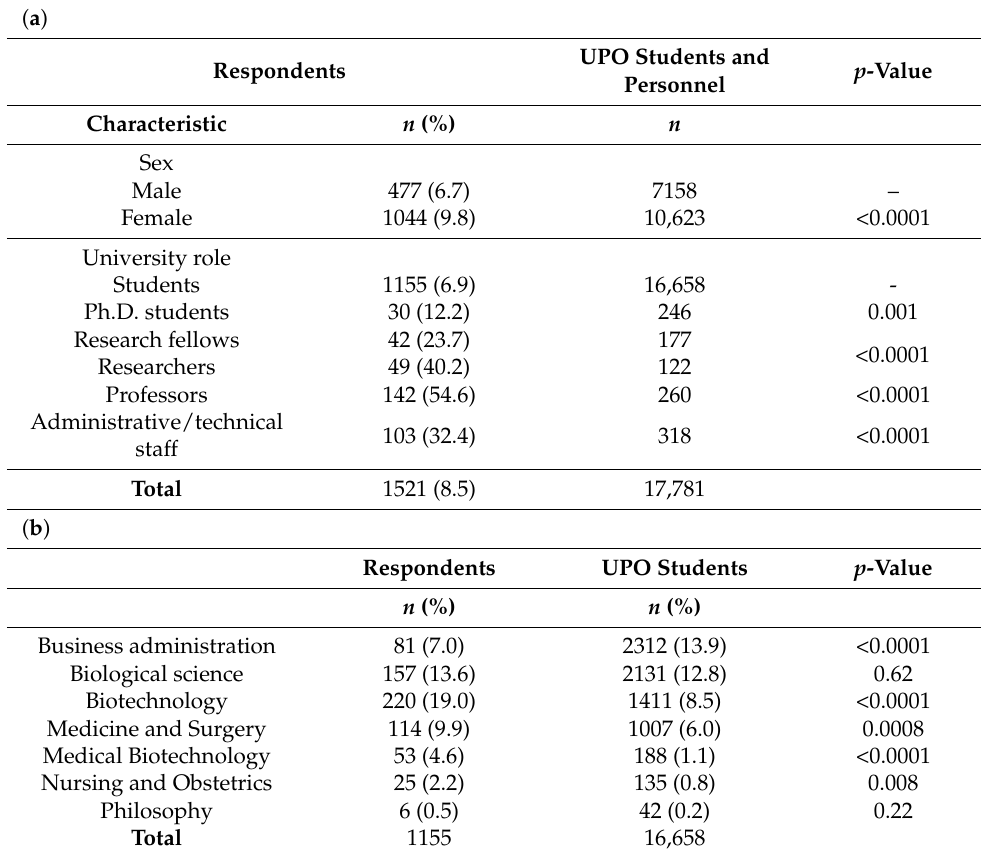
Table 1. ( a ) Demographic characteristics of UPO students and personnel and those of